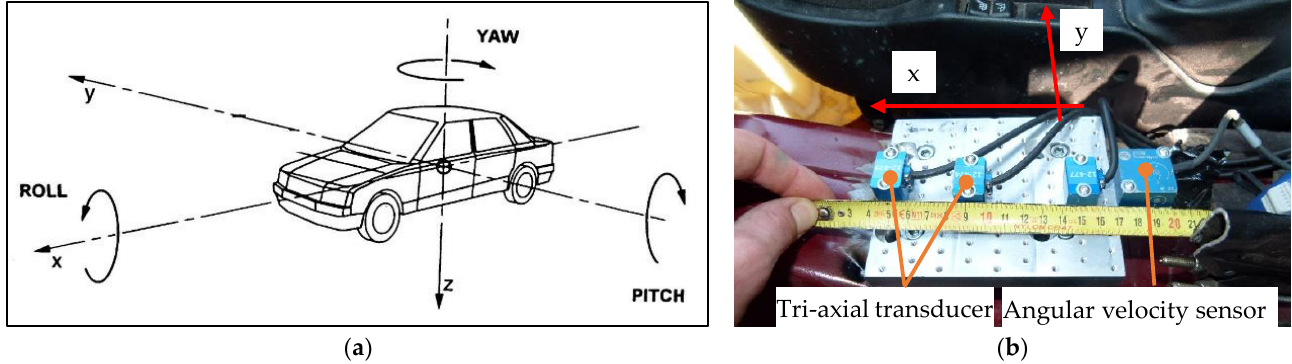
8 of 21 Table 3. Test matrix of the performed tests. Vehicle